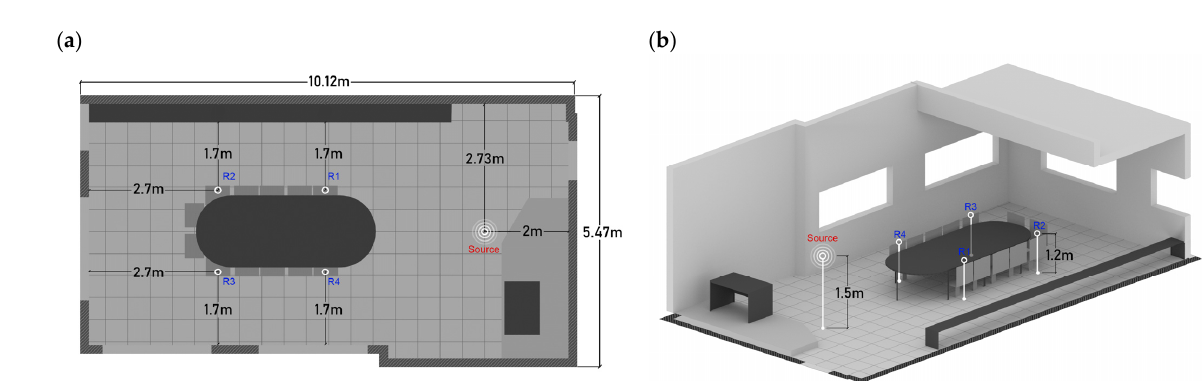
Figure 6. In situ measurements of the classroom. The setup is formed by one source placed 2 m from the whiteboard, central with re- spect to the classroom’s layout, and four receivers having at least 1.5 m distance from the the ground (representing a standing teacher), whilst the receivers’ height was set to 1.2 m (representing sitting students).